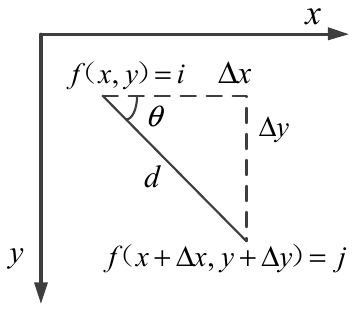
Figure 5. Calculation schematic of gray level co-occurrence matrix (GLCM).